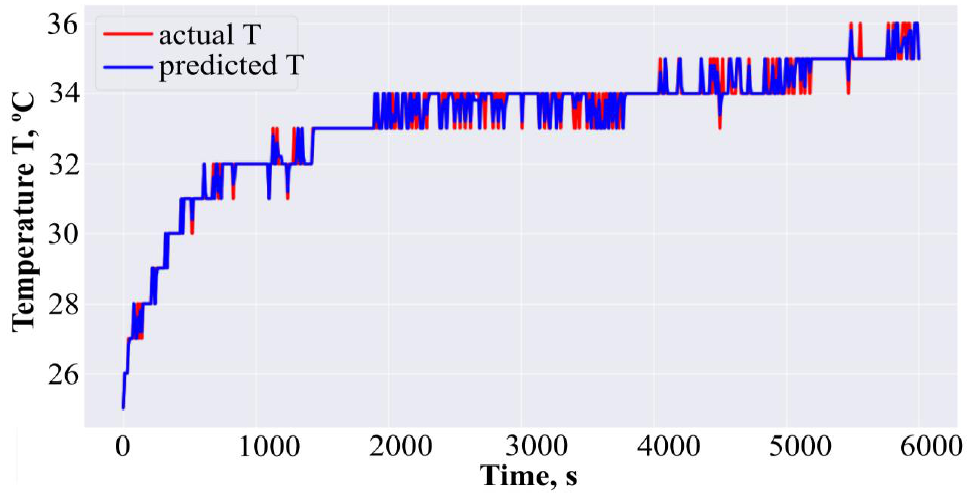
Figure 16. Example of model based on machine learning and real temperature dependence of the solar cell temperature on the time at incident solar power 200 W/m2.